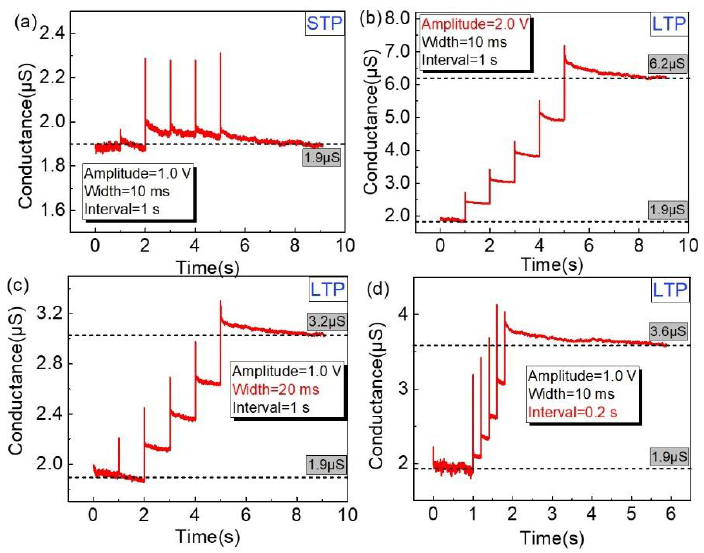
Figure 7. Implementation of transformation from STP to LTP for the NP-embedded devices with the insets of stimuli parameters; the transformation from ( a ) STP to LTP was realized through ( b ) increasing the stimuli amplitude, ( c ) extending the stimuli width, or ( d ) enlarging interval times between stimuli.